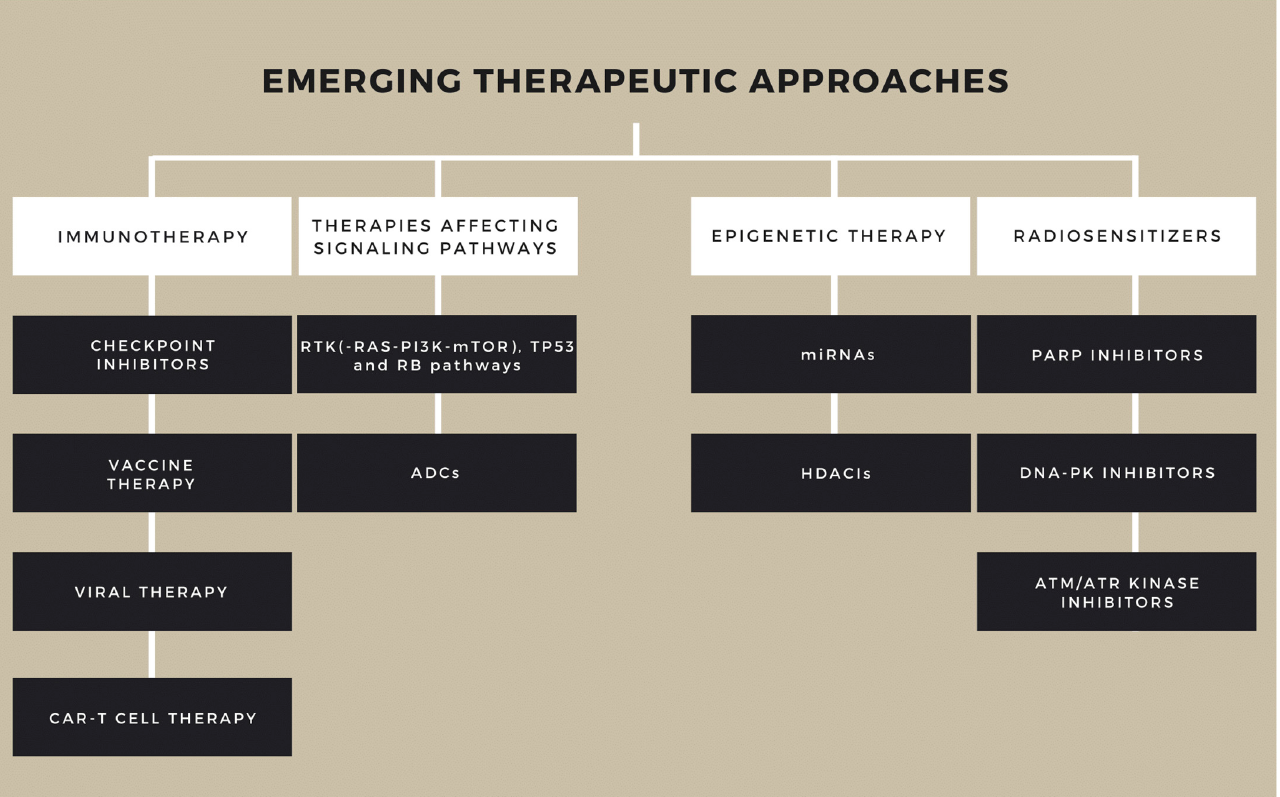
Figure 4. Novel treatment modalities in glioblastoma. At present the gold standard therapy is used worldwide, but promising new agents are under trial. Abbreviations: ADCs: Antibody drug conjugates; RTKs: Receptor tyrosine kinases; RAS: Rat sarcoma virus protein family; PI3K: Phosphoinositide 3-kinase; mTOR: mechanistic target of rapamycin; HDACIs: Histone deacetylase inhibitors; CAR: Chimeric Antigen Receptor; Rb: Retinoblastoma; p53: Cellular tumor antigene p53; miRNAs: microRNAs; PARP: Poly (ADP-ribose) polymerase; DNA-PK: DNA-dependent protein kinase; ATM/ATR: Ataxia telangiectasia mutated/ATM and RAD3-related.